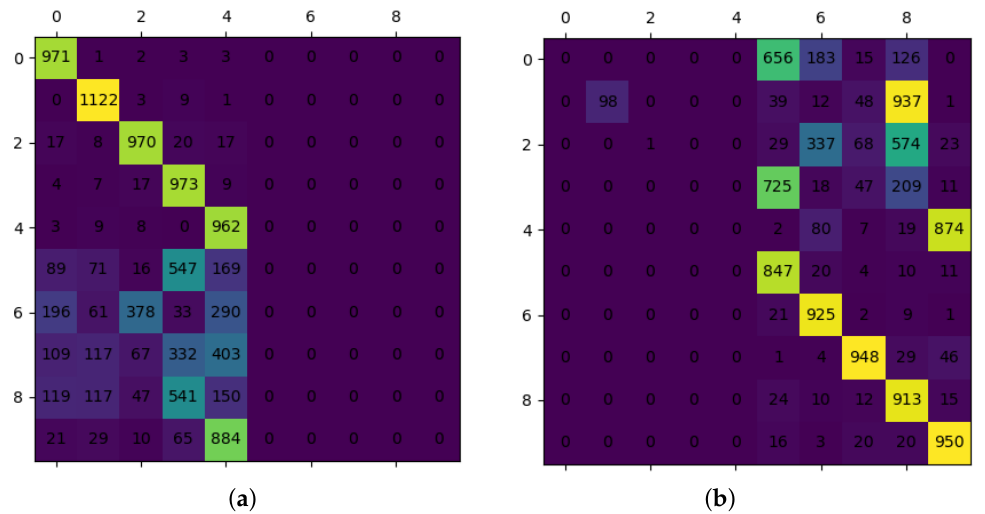
Figure 4. Simple incremental task flow in groups of five classes. ( a ) Incremental task1. ( b ) Incremental task2. Solution: Self-Attention and Total